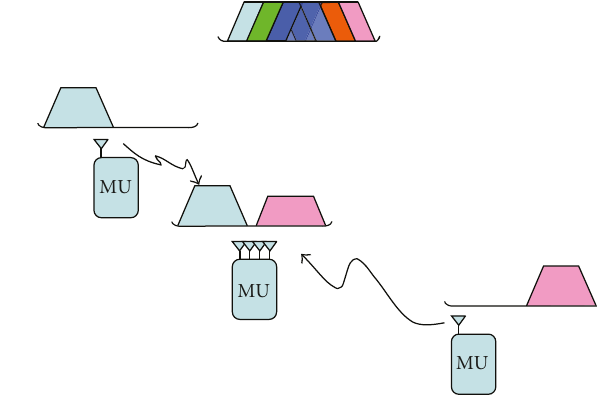
Figure 3: One multiband terminal receiving signals from two over mobile units on nonoverlapped